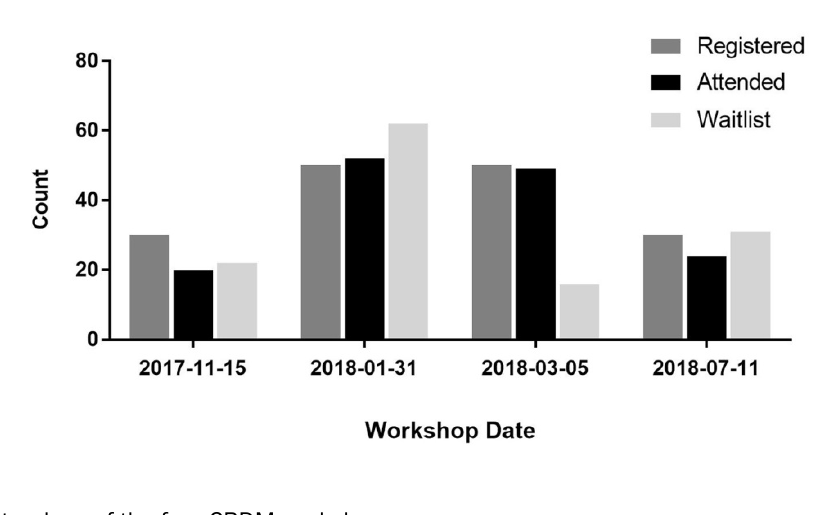
Figure 2 Roles of attendees of the four CRDM workshops